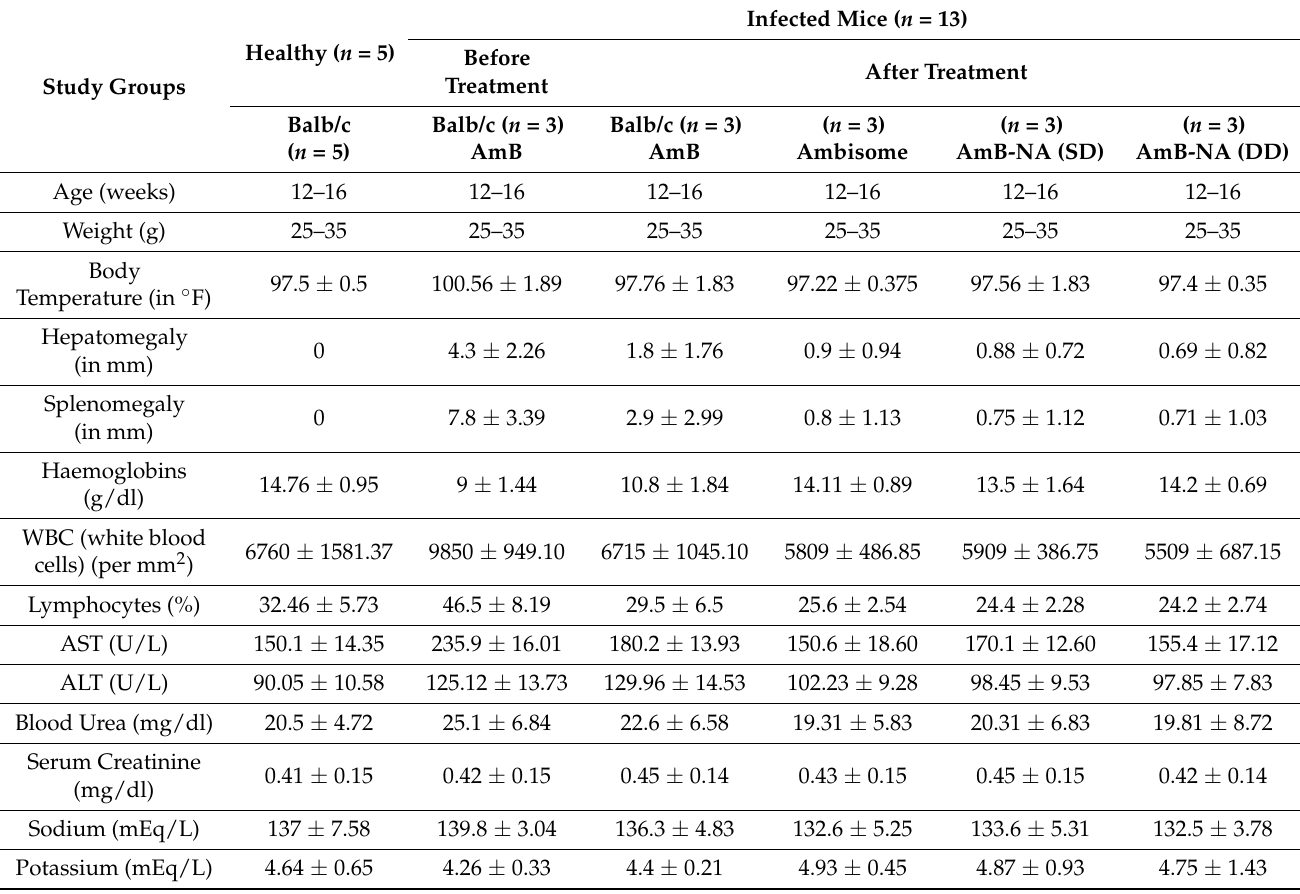
Table 3. Clinical symptoms, hematological as well as biochemical parameters of control and infected mice before and after anti-leishmanial